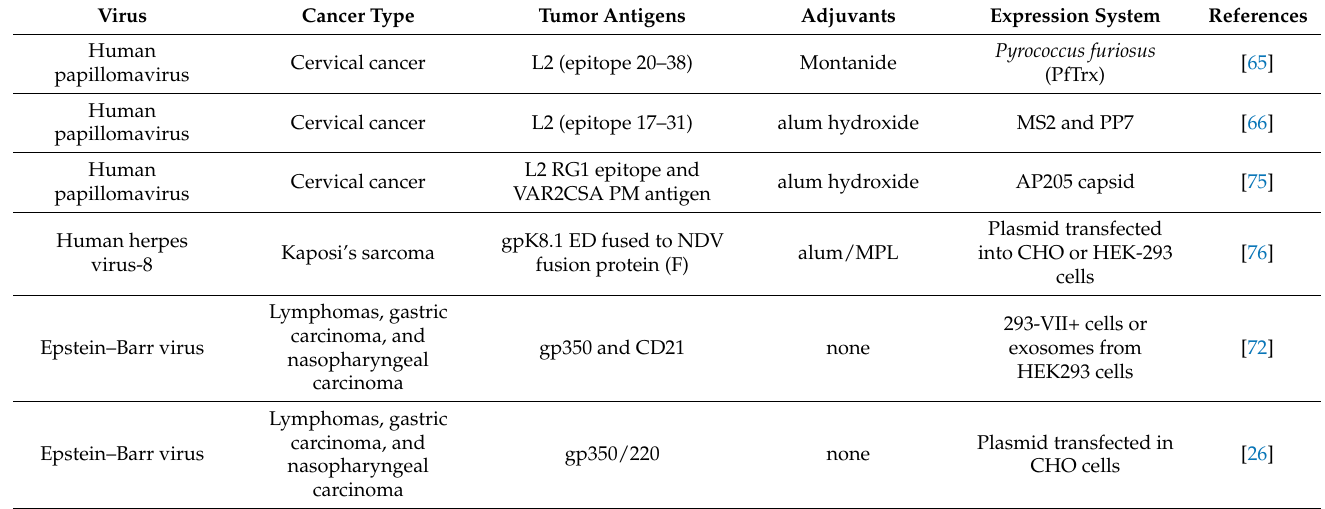
Table 2. Prophylactic VLP vaccine against oncoviruses in preclinical